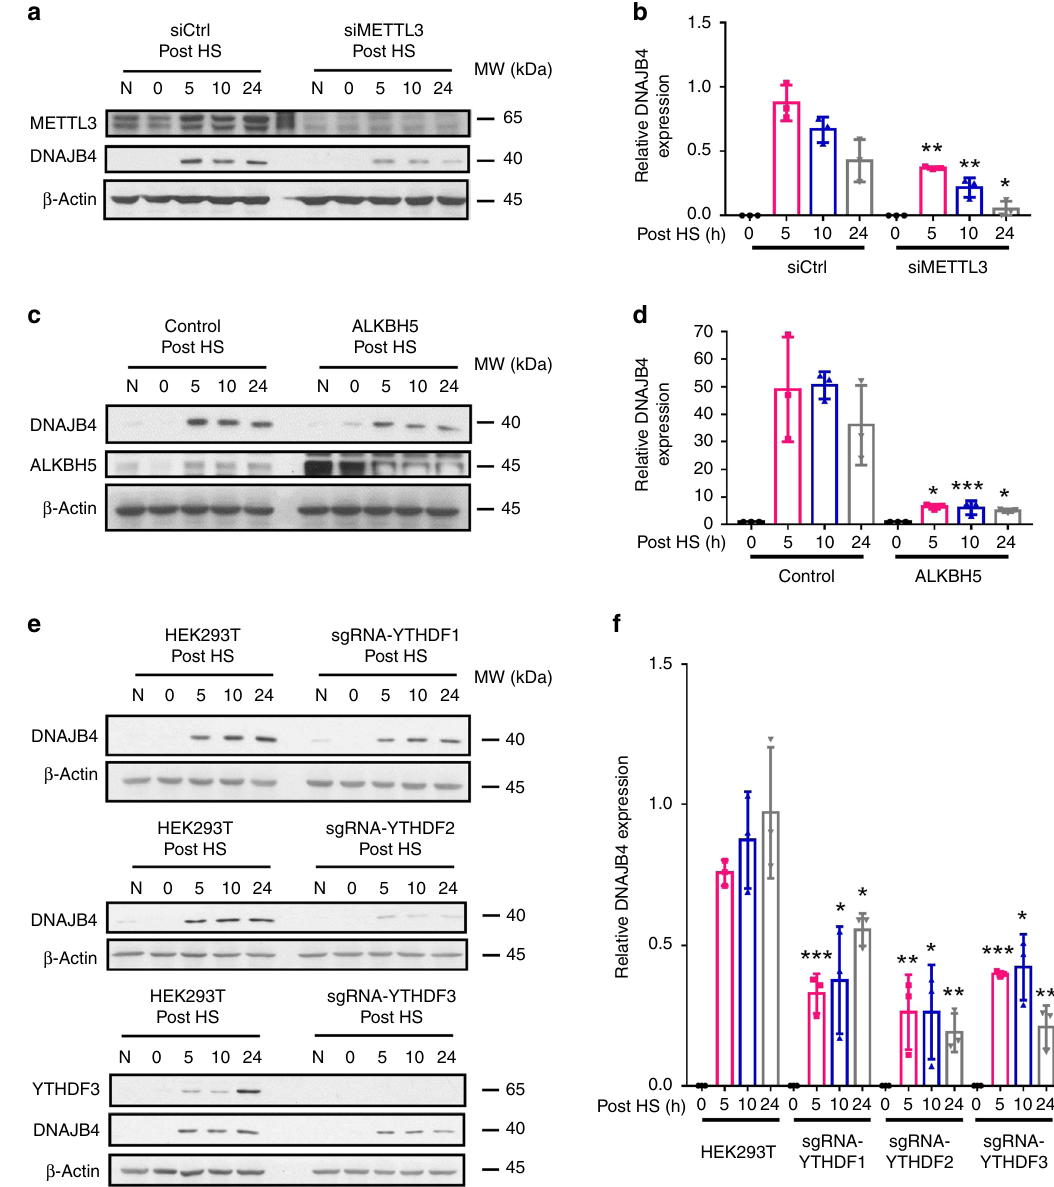
Fig. 7 Heat shock induces elevated expression of DNAJB4 via m 6 A. Shown in ( a ), ( c ) and ( e ) are western blot images displaying the expression levels of DNAJB4 in M14 cells following heat shock treatment (HS, at 42.0 °C for 60 min), or the same cells after siRNA-mediated knockdown of METTL3 (siMETTL3 – 1) ( a ), ectopic overexpression of ALKBH5 ( c ), or the isogenic HEK293T cells with YTHDF1, YTHDF2, or YTHDF3 genes being knocked out by the CRSIPR-Cas9 genomic editing method ( e ). The relevant quanti fi cation data are presented in ( b ), ( d ) and ( f ). β -actin was employed as the loading control in ( a ), ( c ) and ( e ). Shown in ( b ) and ( f ) are the ratios of expression of DNAJB4 protein over β -actin, and in ( d ) these ratios were further normalized to the ratios obtained for the cells at t = 0 post heat shock. The quanti fi cation data in ( b ), ( d ) and ( f ) represent the mean ± S.D. of results from three independent experiments. The p -values referred to the comparison between control cells and siRNA-mediated knockdown ( b ) or ectopic expression ( d ) of the indicated genes, or HEK293T cells and the isogenic cells with YTHDF1/2/3 genes being individually ablated ( f ). The p- values were calculated based on unpaired, two-tailed Student ’ s t -test: *, 0.01 ≤ p < 0.05; **, 0.001 ≤ p < 0.01; ***, p < 0.001. Source data are provided as a Source Data fi